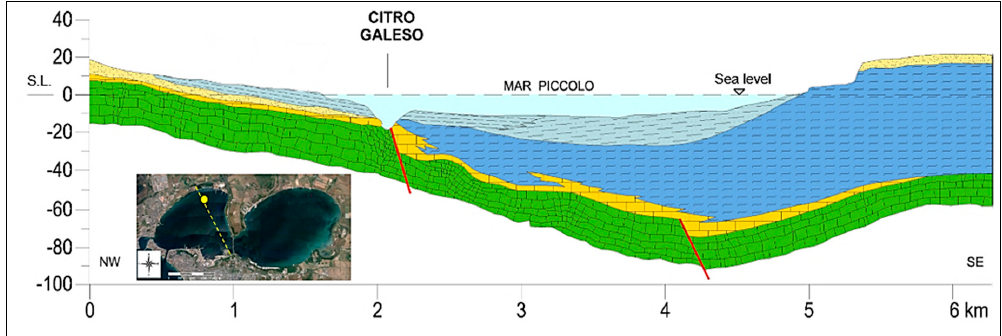
Figure 2. Mar Piccolo: geological sketch ([19,20]).